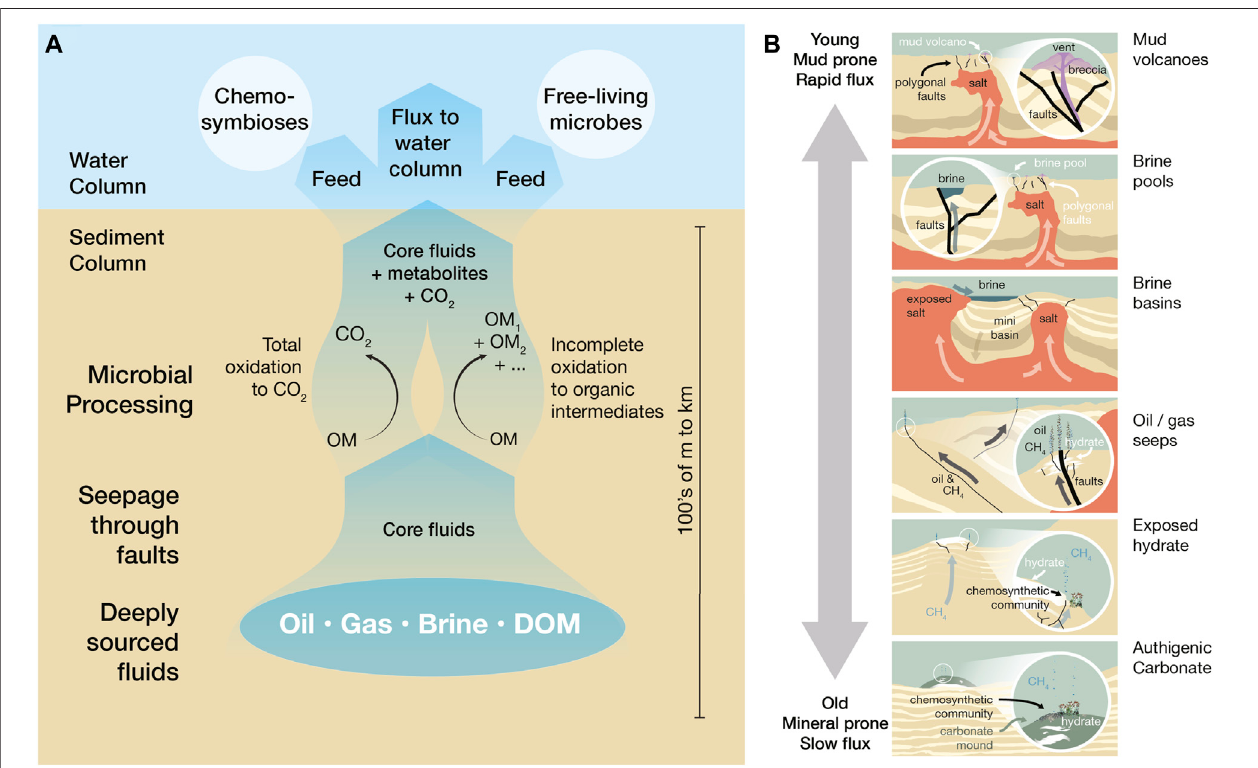
FIGURE 1 | (A) The fl uids that fuel hydrocarbon seeps fall into four categories: oil, gas, brine, and dissolved organic matter (DOM), and are arranged like this: oil + gas and oil + gas + brine + DOM. During transit, fl uids are altered by biotic and abiotic processes. Upon discharge, these organic rich substrates fuel activity free-living andchemosymbioticassociations. (B) Arangeofseepenvironmentsfrommud-pronesystems — includingmudvolcanoes,brinepools,andbrinebasins — tooilandgas seeps with gas hydrate and low fl ow systems dominated by authigenic carbonates. Adapted from Joye (2020).